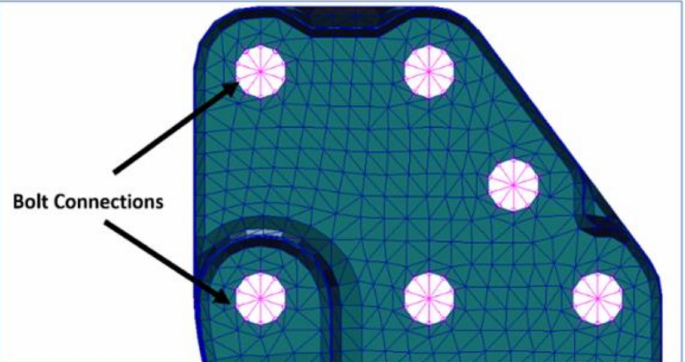
Figure 9. Simplification of bolted